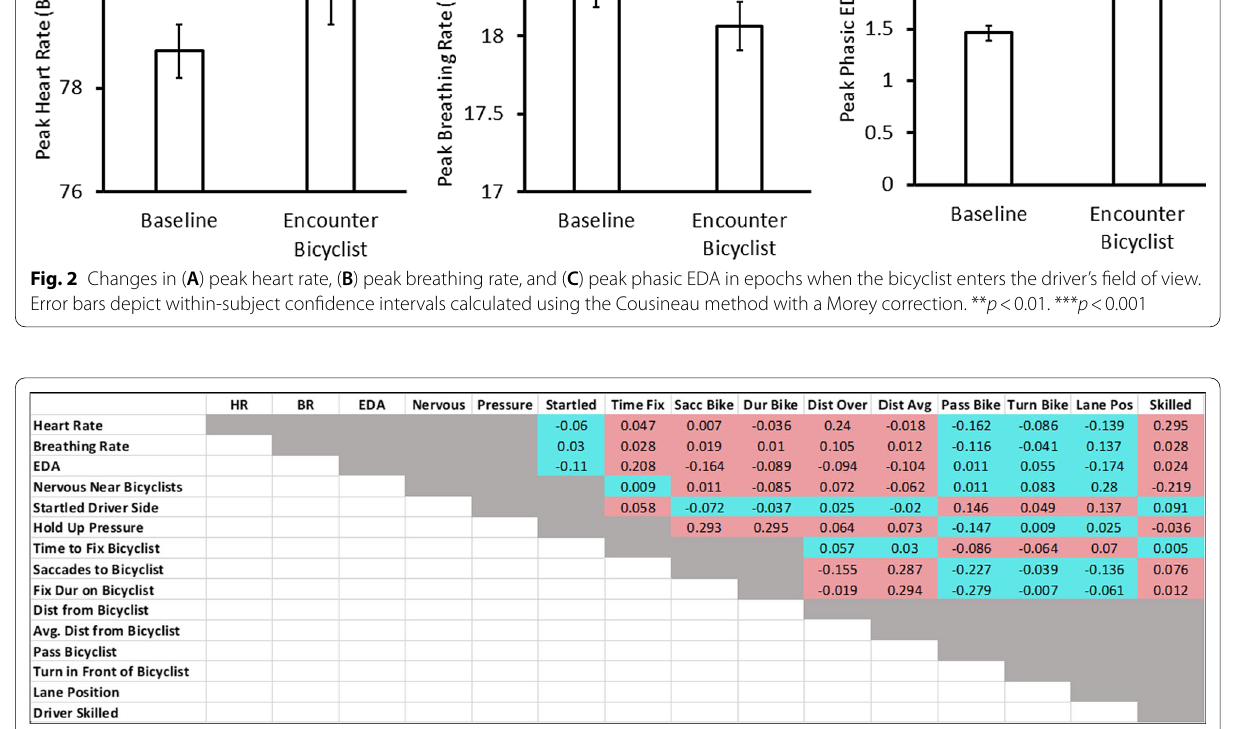
Fig. 3 Correlation matrix containing physiological, eye-tracking, driving, and questionnaire measures, color-coded based on predictions arising from the hypothesis that anxiety promotes safer interactions with bicyclists while driving (red